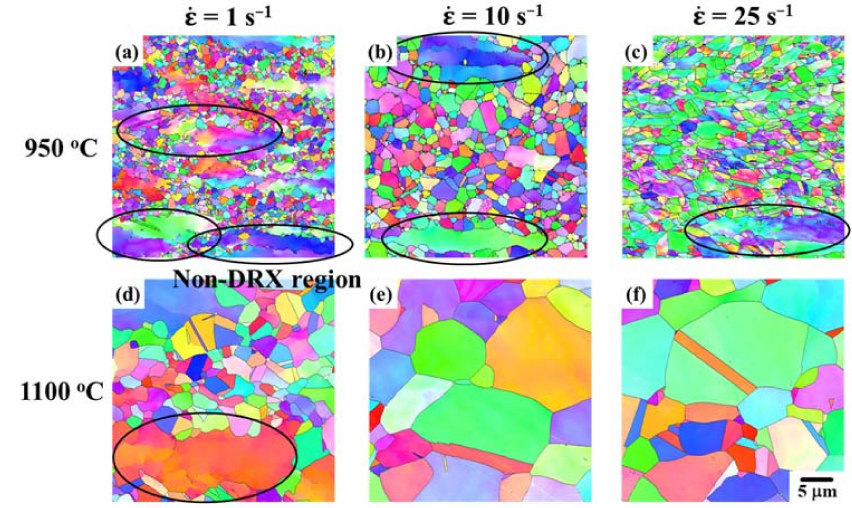
Figure 5. Microstructural evolution of superalloy 718 compressed at 67% height reduction, deforma- tion temperatures of ( a – c ) 950 ◦ C and ( d – f ) 1100 ◦ C, and strain rates of ( a , d ) 1 s − 1 , ( b , e ) 10 s − 1 , and ( c , f ) 25 s − 1